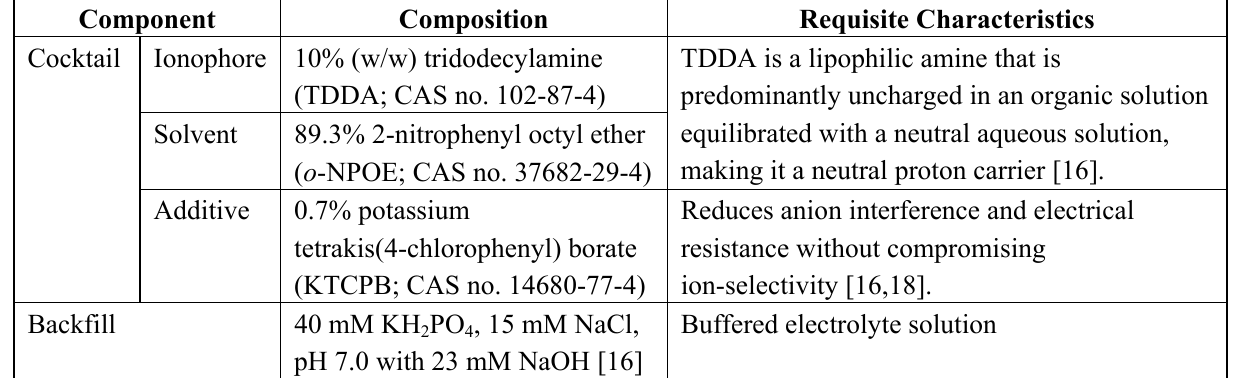
Table 1. The composition and components of H + -selective ionophore I cocktail B (Sigma cat. no. 95293) and associated backfill solution. CAS (Chemical Abstracts Service) Registry numbers are provided for uncommon chemical components. Further details are provided at The Sensor Application Portal hosted at